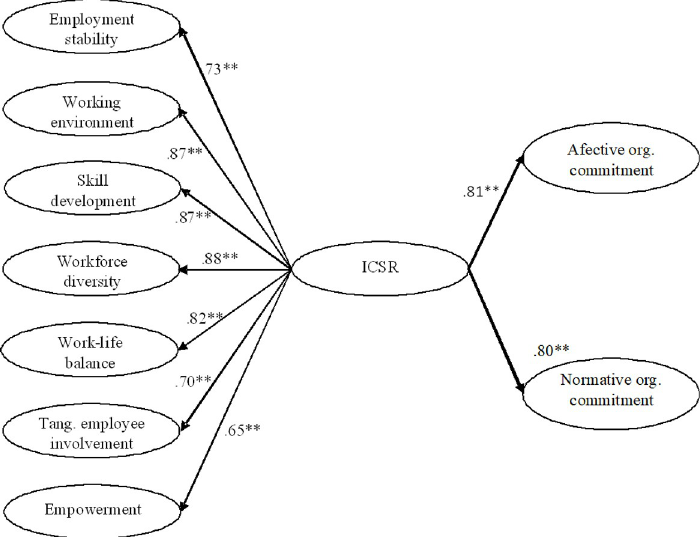
Fig 3. Structural model for ICSRQ and organizational commitment. Note . Standardized loadings. �� p <